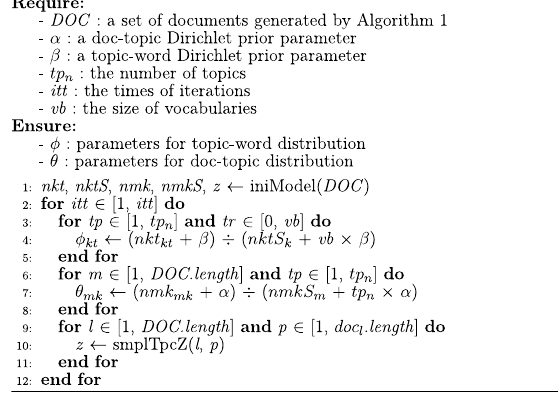
Algorithm 2. Service topic model